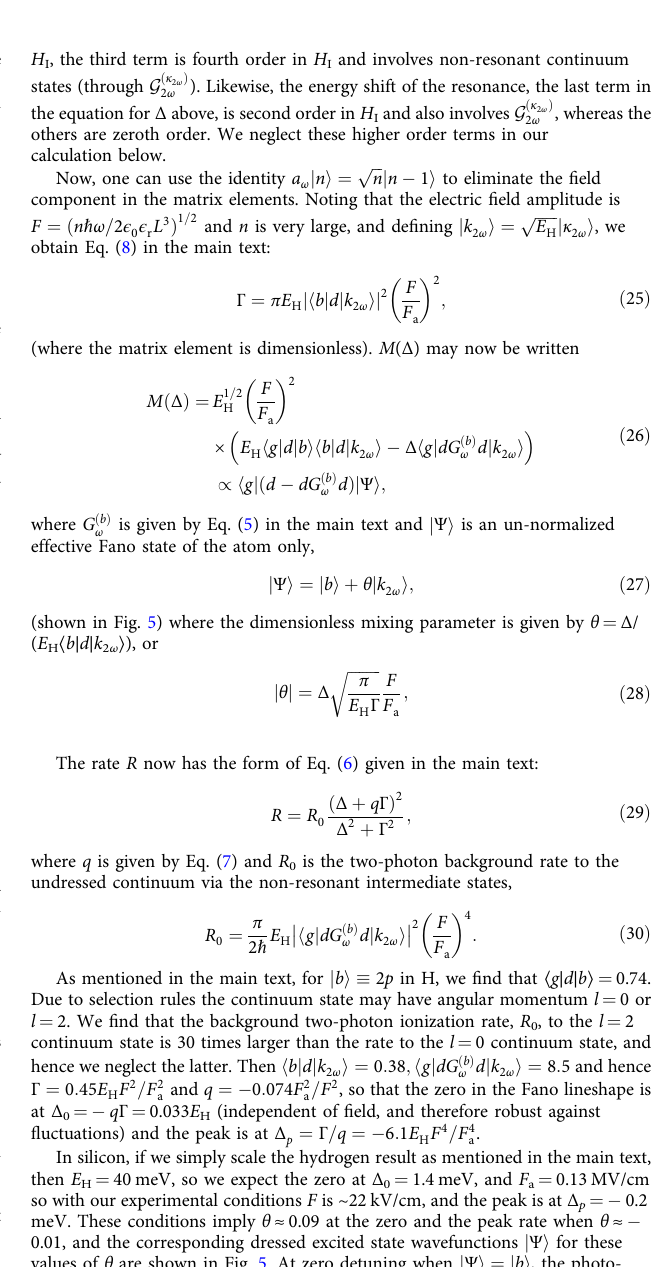
Fig. 5 The MPICS wavefunction. Ψ ( r ) ∝ b ( r ) + θ k 2 ω ( r ) is shown for b j i (cid:2) 2 p amplitude, normalized to the maximum in